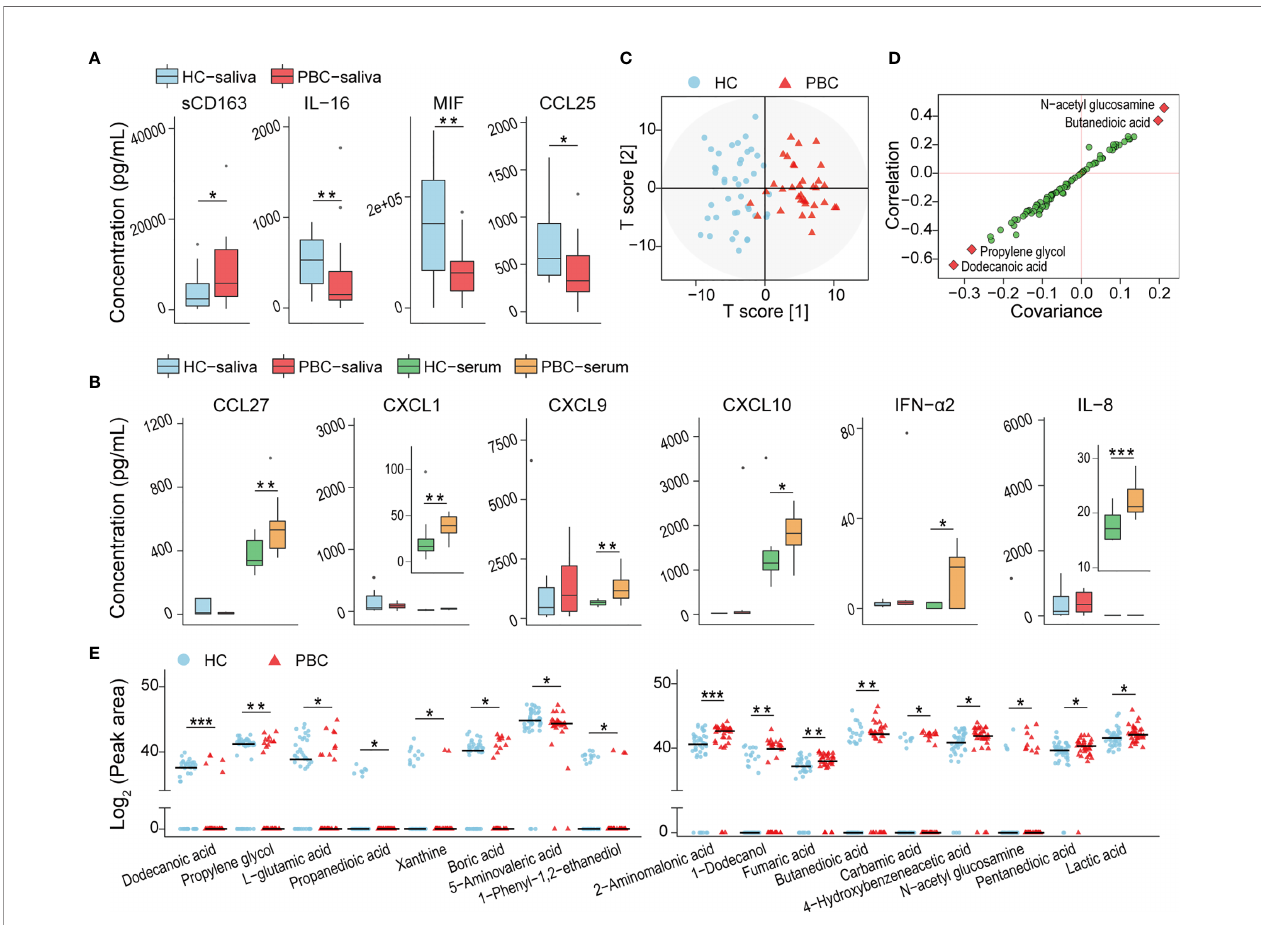
FIGURE 2 | In fl ammatory cytokines and harmful metabolites were enriched in PBC saliva compared with that in HC saliva. (A) In fl ammatory cytokines were distributed differently in PBC saliva and HC saliva. (B) The levels of certain cytokines with nonsigni fi cant differences between HC and PBC saliva were increased signi fi cantly in PBC serum. (C) OPLS-DA plots of the metabolome illustrating that PBC and HC subjects were clearly separated. (D) S-plot highlighting four salivary metabolites as potential biomarkers. (E) Seventeen salivary metabolites were different in peak areas and/or detection rates between HC and PBC samples. * P <